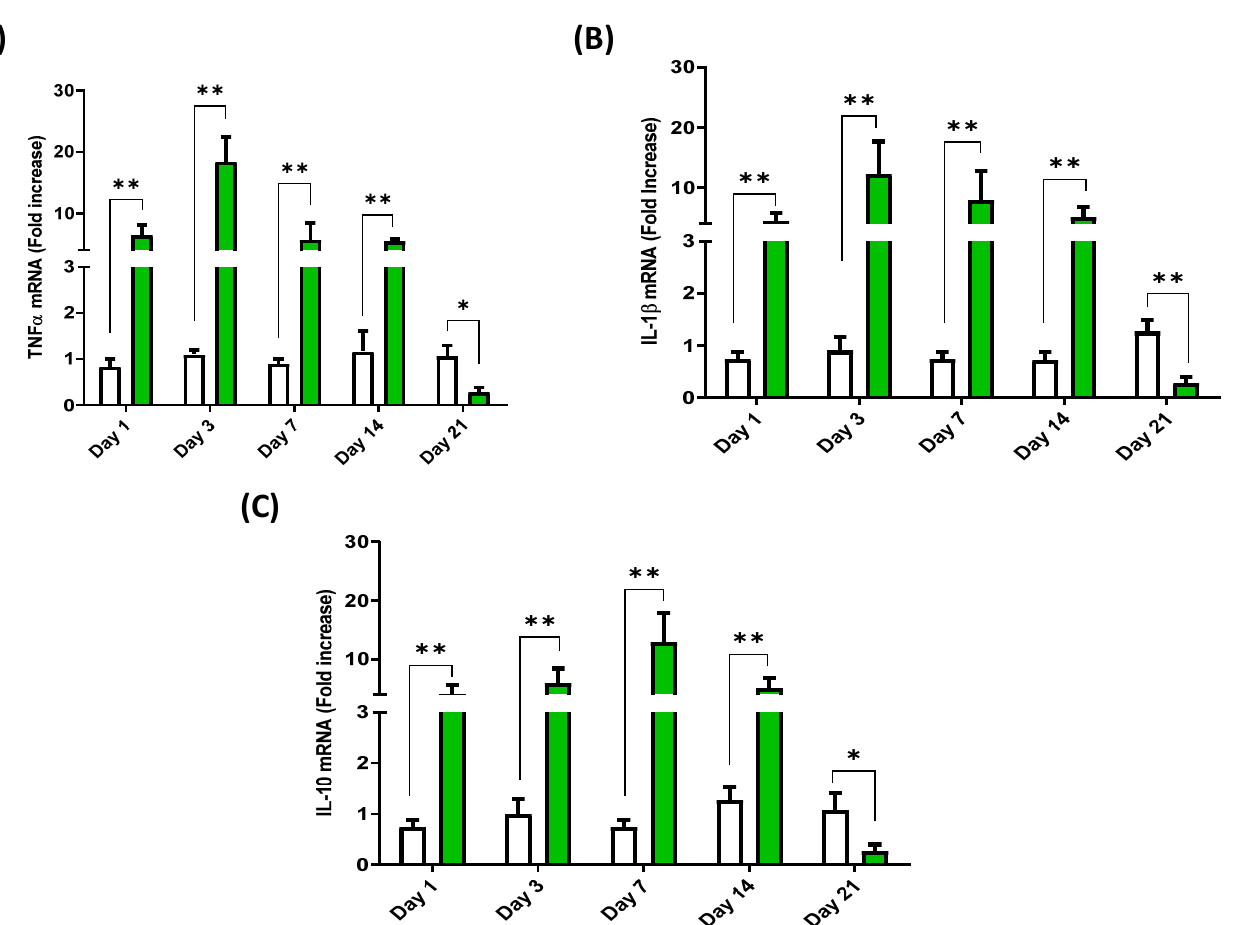
Figure 4. Head kidney cytokine mRNA expression profile of European sea bass injected with Hep20. TNF α ( A ), IL-1 β ( B ) and IL-10 ( C ) mRNA expression in the head kidney of European sea bass after Hep20 intraperitoneal injection (green bars). The graph shows the cytokine fold induction compared to the control group, i.e., fish injected with phosphate-buffered saline (white bars). Significant differences ( p < 0.05 or p < 0.01) between groups at each time are indicated by (*) or (**) respectively ( n = 6).